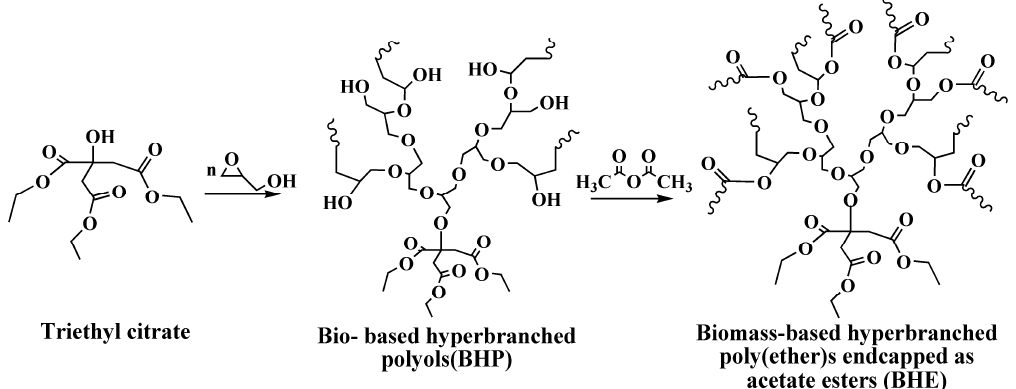
Figure 1. Synthesis of biomass-based hyperbranched poly(ether)s end-capped as acetate esters (BHE).